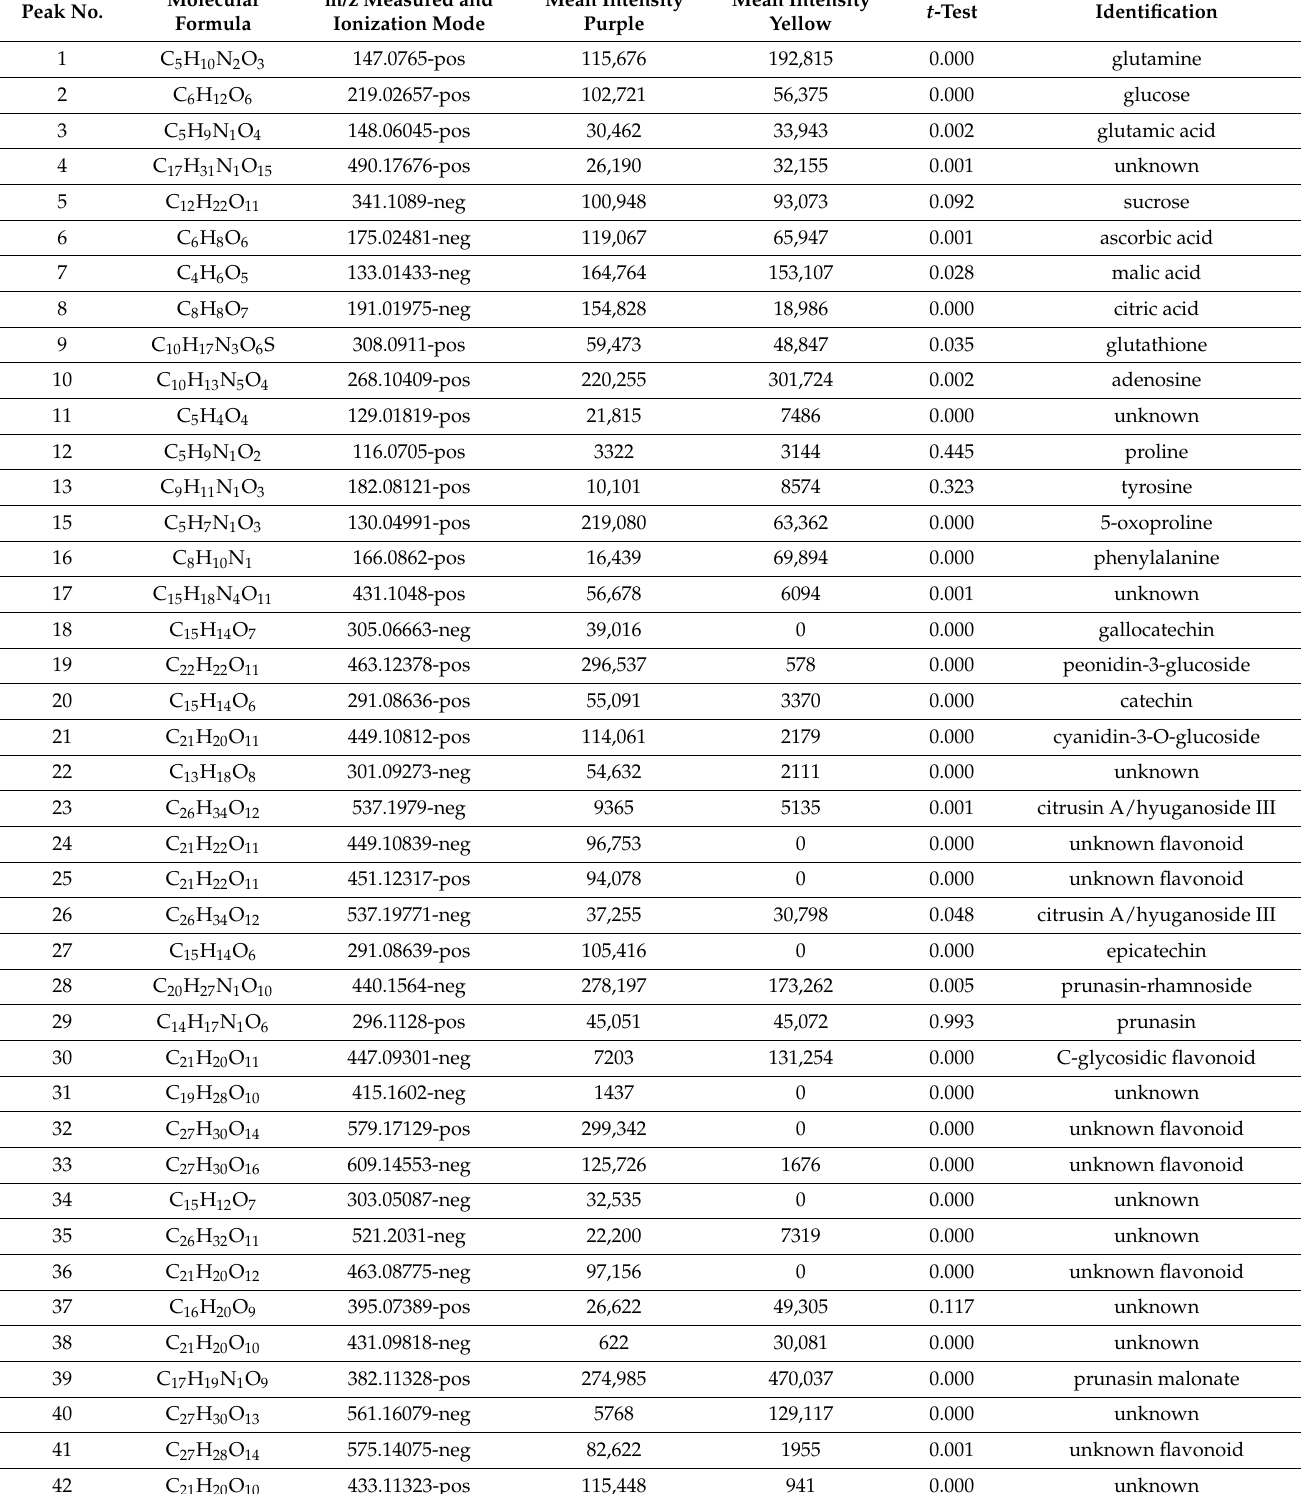
Table 6. Mean peak intensities for metabolites partially identified in peels of the purple and yellow passion fruit cultivars by LC-ESI-Q-ToF-MS. (cf. Methods and Materials). Metabolites with highest intensities and differences between the purple and yellow cultivars are shown. Based on three independent experiments. Compounds are listed in order of retention time. Peak